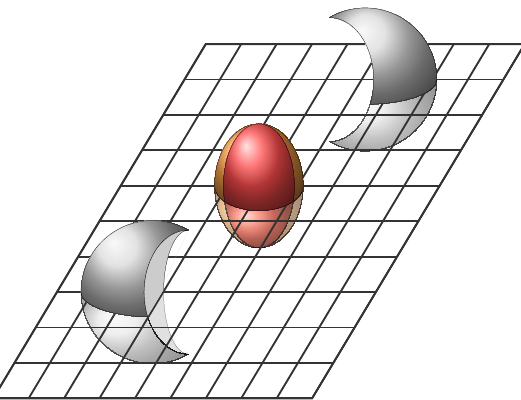
Figure 1 . Sketch of a peripheral heavy ion collision. The almond shaped overlap region forms a quark-gluon plasma, not the spectator portions (shown in grey). The hydrodynamization time increases rapidly as one approaches the boundary of the overlap region, whose shape influences the value of the experimentally measured elliptic flow parameter v 2